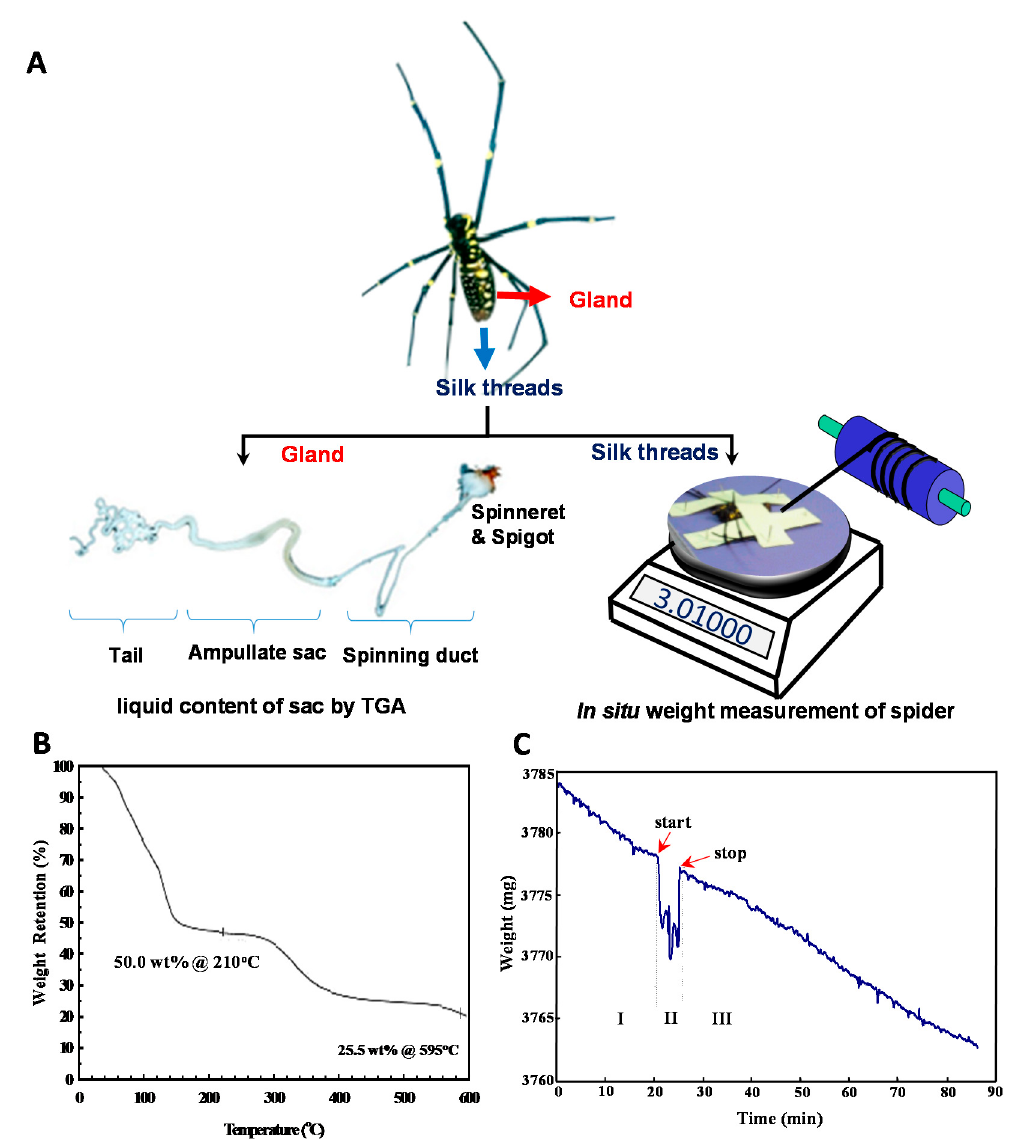
Figure 2. Measurement of spider silk concentrations along the spinning process of N. pilipes . ( A ) Schematic for assessing the liquid concentration of the silk dope at different locations in the spinning pathway. The concentration of silk in the gland sac harvested from a spider was estimated via thermogravimetric analysis (TGA) ( left ). The concentration of silk exiting the spigot was gauged by monitoring the weight loss of the spider on the microbalance and the weight of the collected dried silk ( right ). ( B ) The TGA weight percentage of the liquid silk sample shown in the left side of Figure 2A. ( C ) Real-time body mass change of the spider in the process of (I) pre-silking, (II) peri-silking, and (III) post-silking upon forced-spinning via the winder.